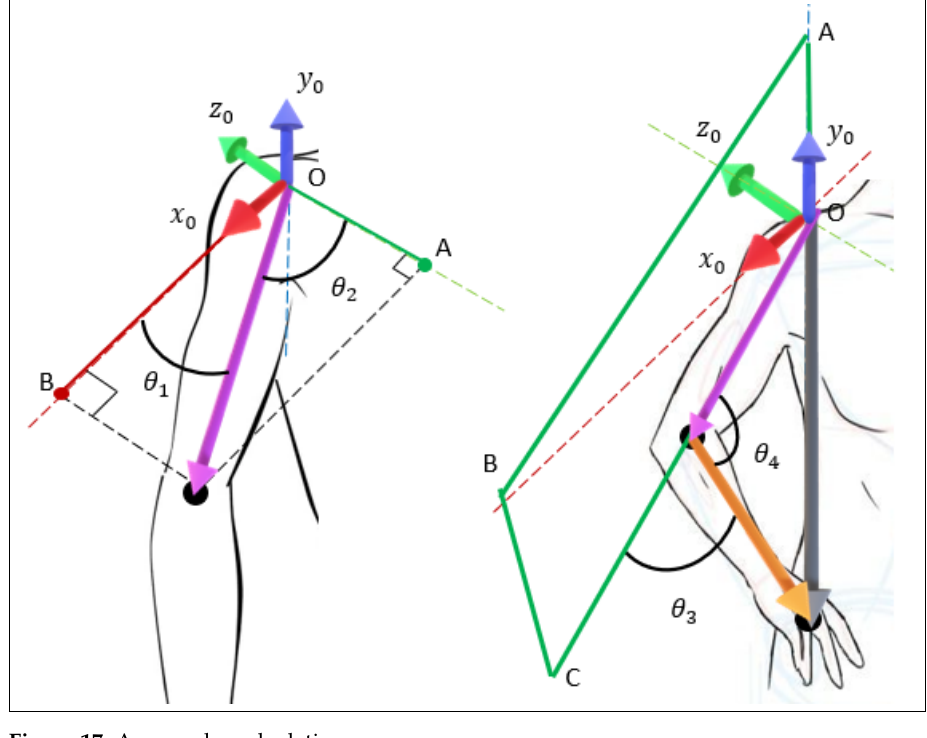
Figure 17. Arm angles calculation.